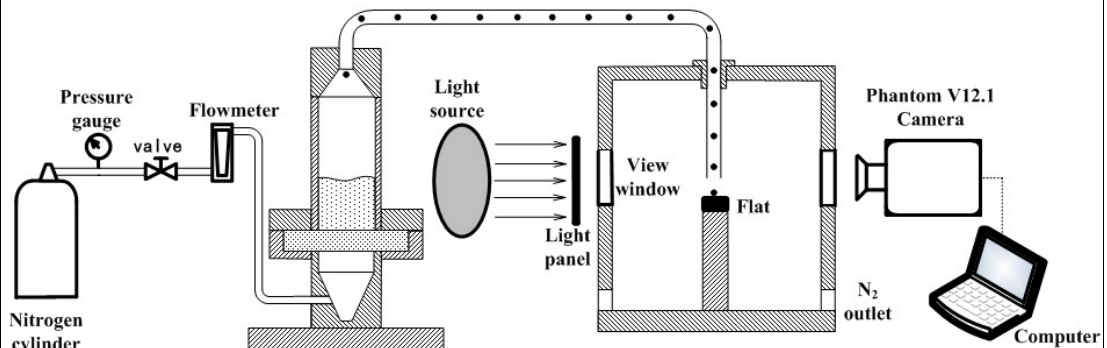
Figure 1. Schematic of the experimental configuration with the high-speed camera system used in the normal impact